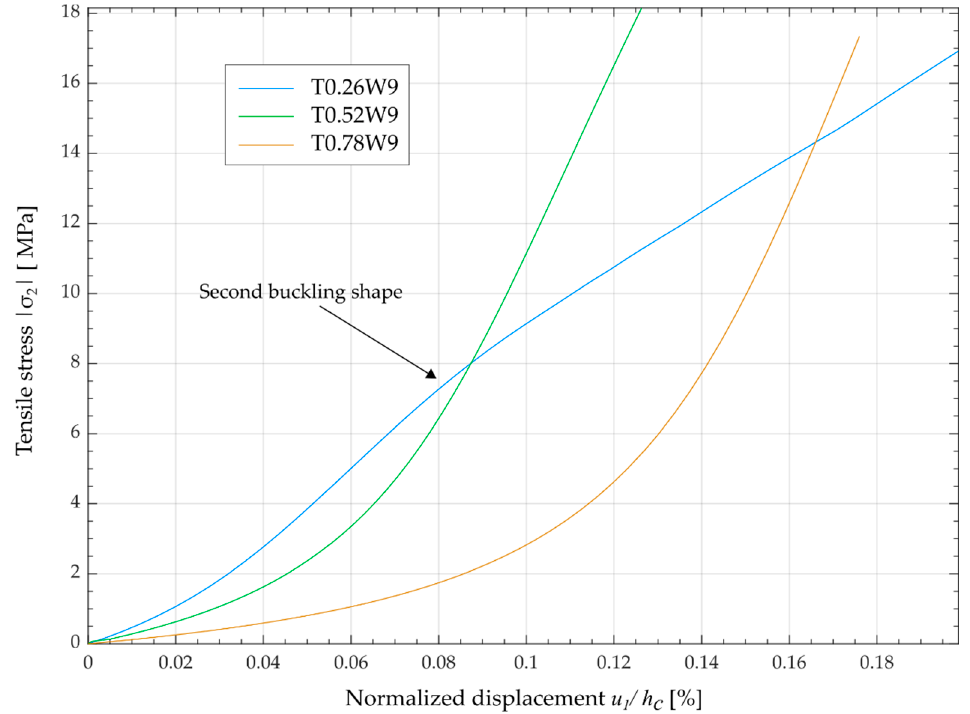
Figure 8. Stresses transverse to fiber direction vs. normalized displacement in 𝑥 (cid:2869) -direction of the unit cell. unit